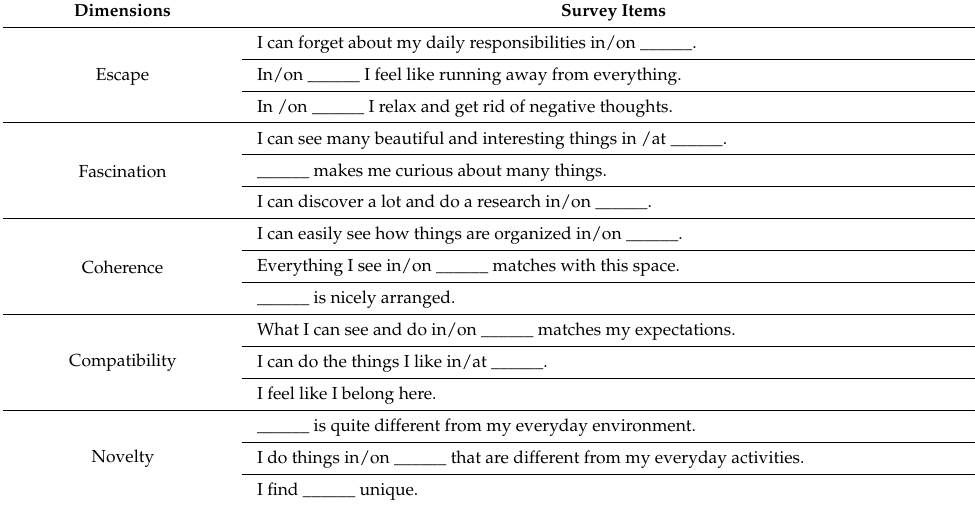
Table 2. Perceived restorativeness items used in the present study, grouped according to the five restorative